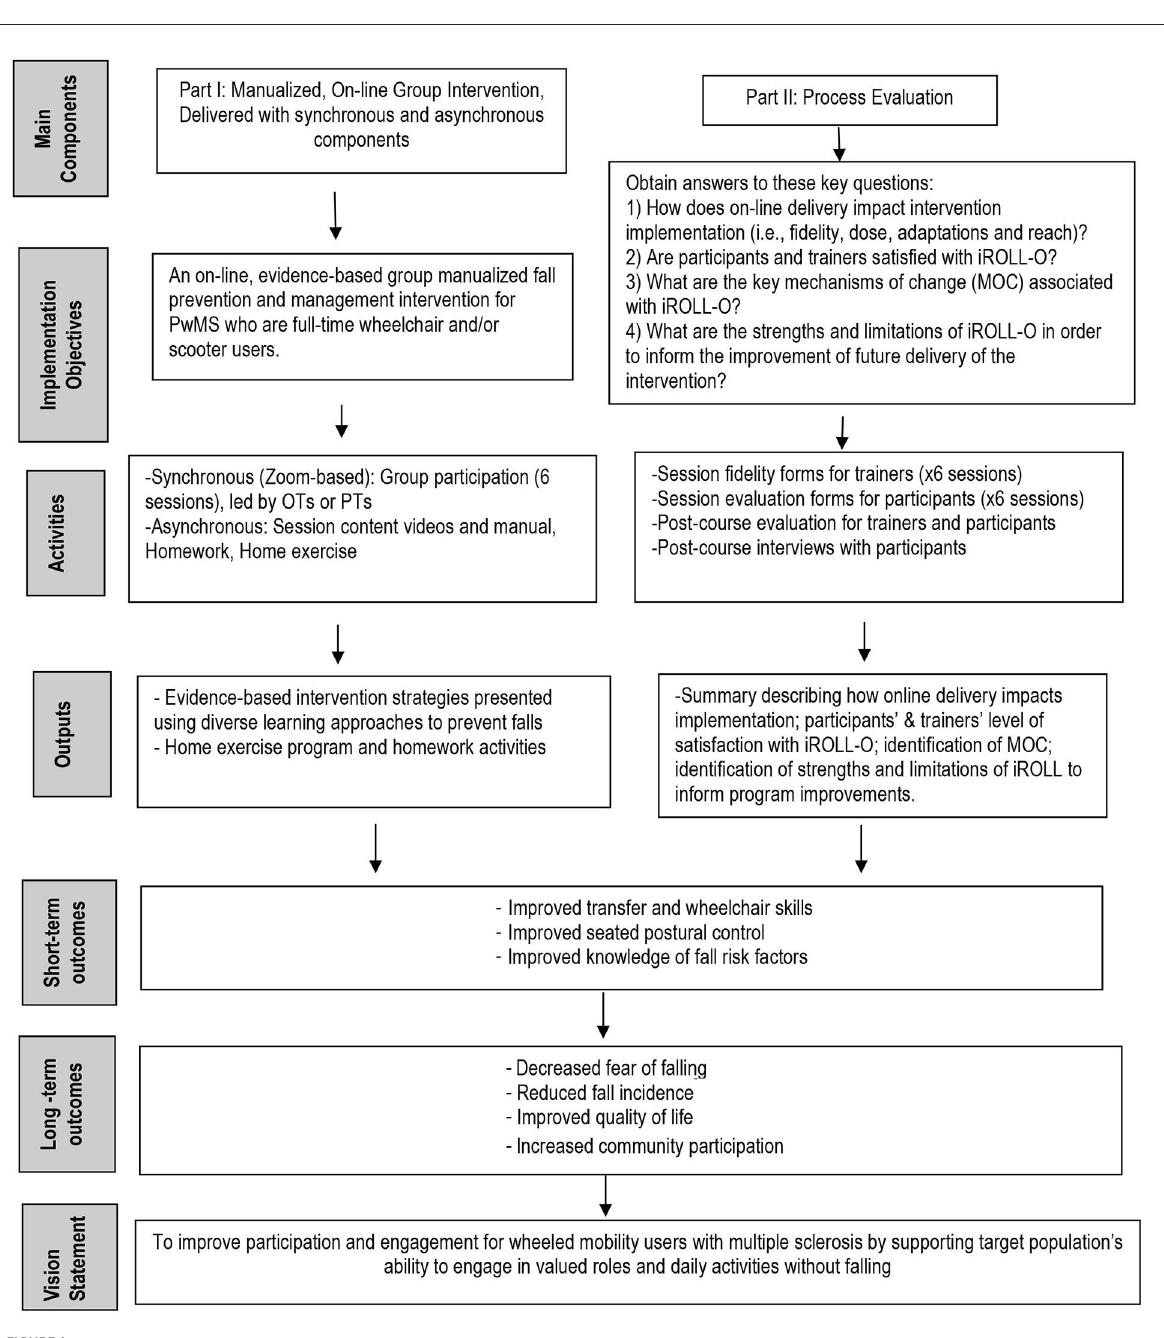
FIGURE1 The iROLL-O intervention and process evaluation logic